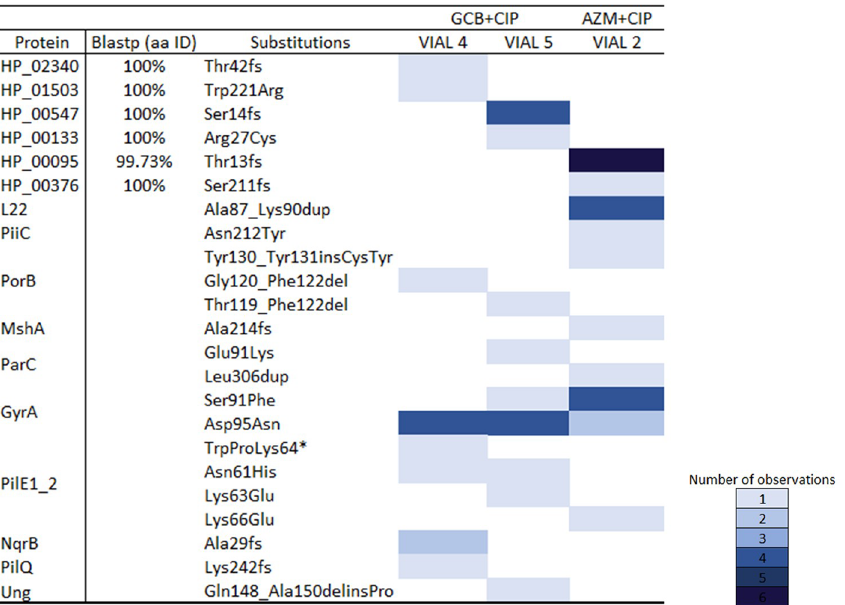
Figure 4. A distribution map of mutated genes under different conditions. (*) refers to a stop